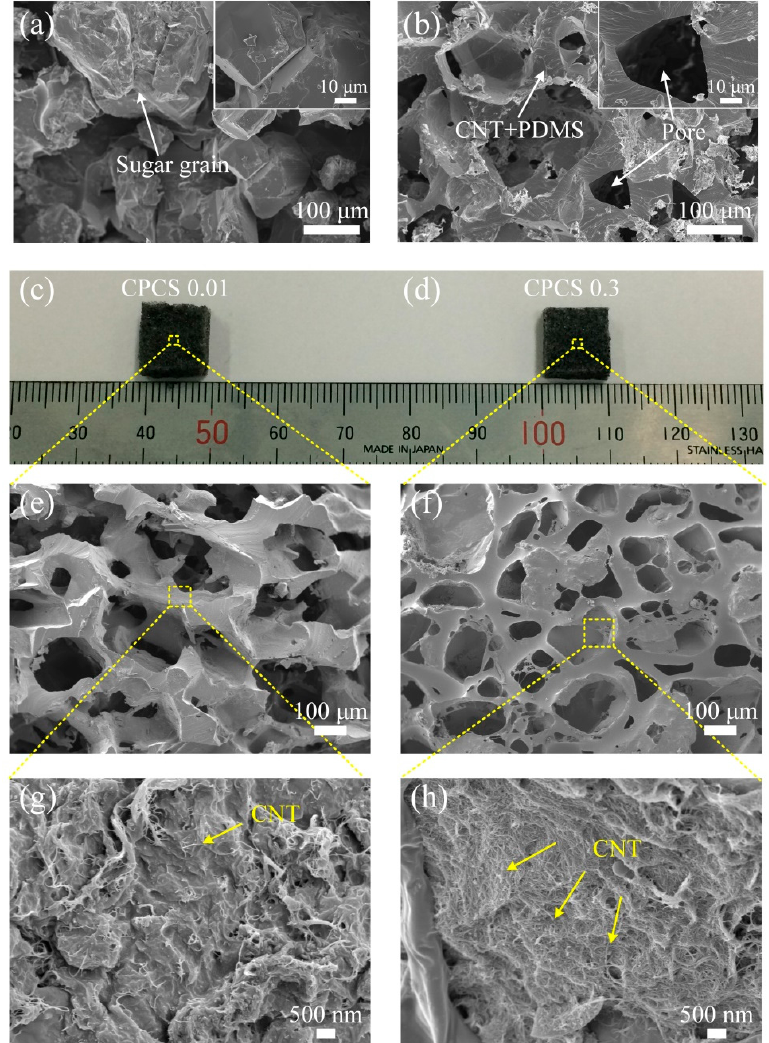
Figure 3. Photos and SEM images of the fabricated sugar cube and CPCS. ( a ) SEM image of the sugar cube. ( b ) SEM image of CPCSs. ( c ) Photograph of CPCS 0.01. ( d ) Photograph of CPCS 0.3. ( e , g ) SEM images of CPCS 0.01. ( f , h ) SEM images of CPCS 0.3. A relatively larger concentration of CNTs exists in CPCS 0.3 than that in CPCS